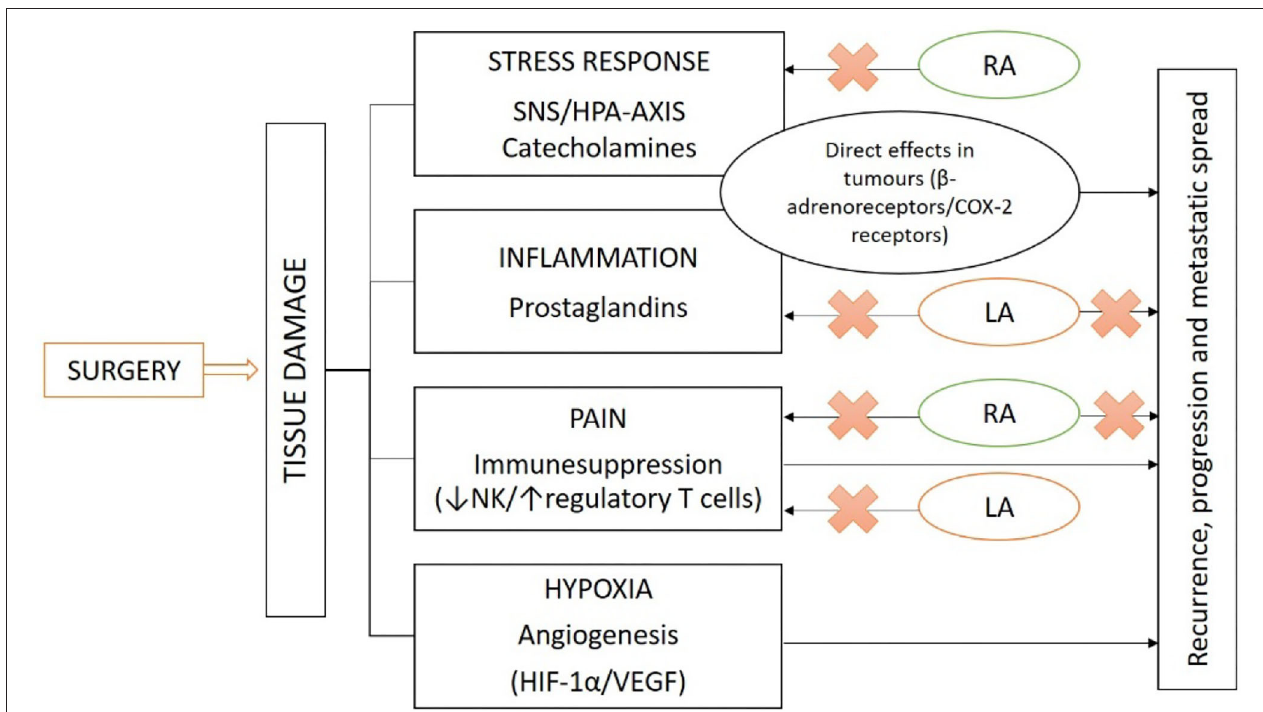
FIGURE 3 | Oncological surgery activates tissue damage, creating an environment of physiological stress response, inflammation, pain, and hypoxia. These cause the release of hormonal mediators (catecholamines, prostaglandins, and growth factors), activating receptors with direct pro-tumor effects and contributing to immune suppression. RA and LA block pain, attenuating many of the adverse effects caused by the neuroendocrine response to surgical stress, proposing oncological benefits (RA, regional anesthesia; LA, local